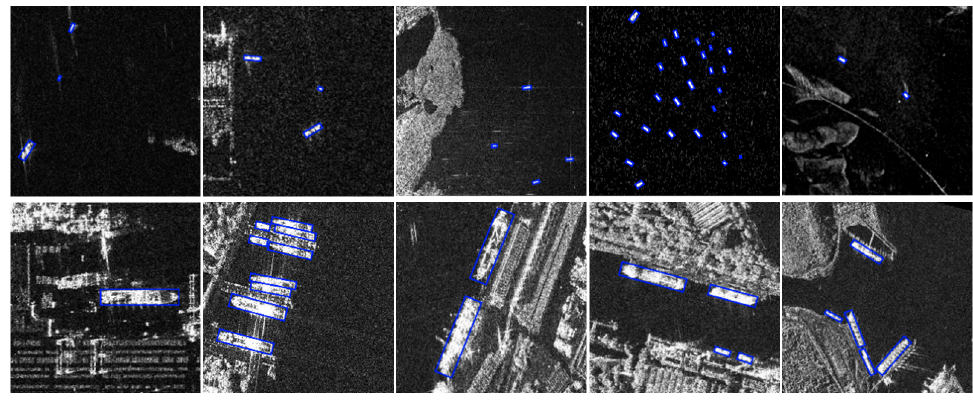
Figure 12. Satisfactory testing results of the SSDD dataset. Both small ships and ships in complex backgrounds can be detected correctly.